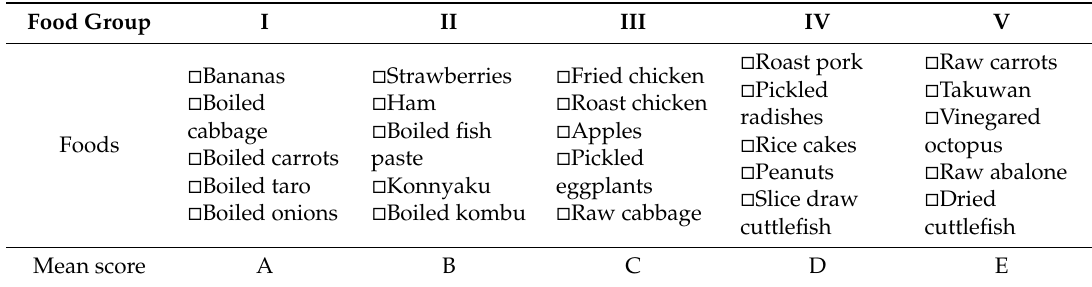
Table 1. The 25 food items and formula for calculating the masticatory score.